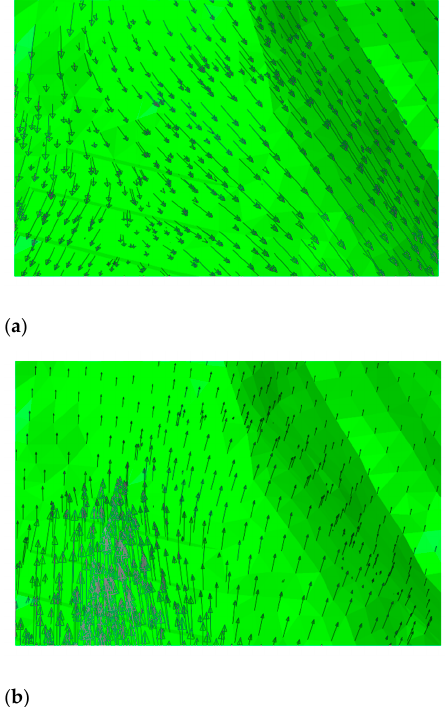
Figure 13. Displacement vector diagram after excavation. ( a ) Slope surface displacement at the beginning of excavation. ( b ) Slope surface displacement after balance after excavation.